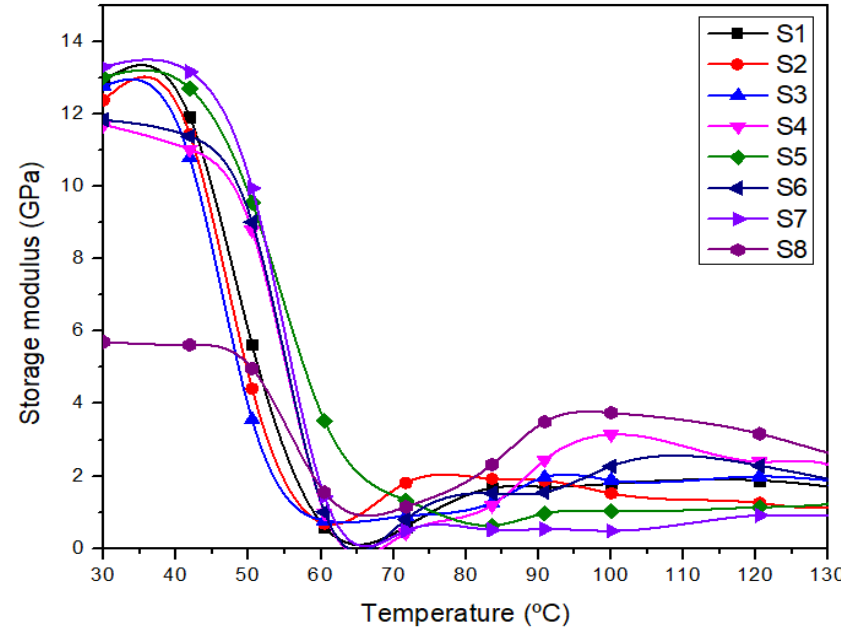
Figure 5. The storage modulus of different laminated composites.